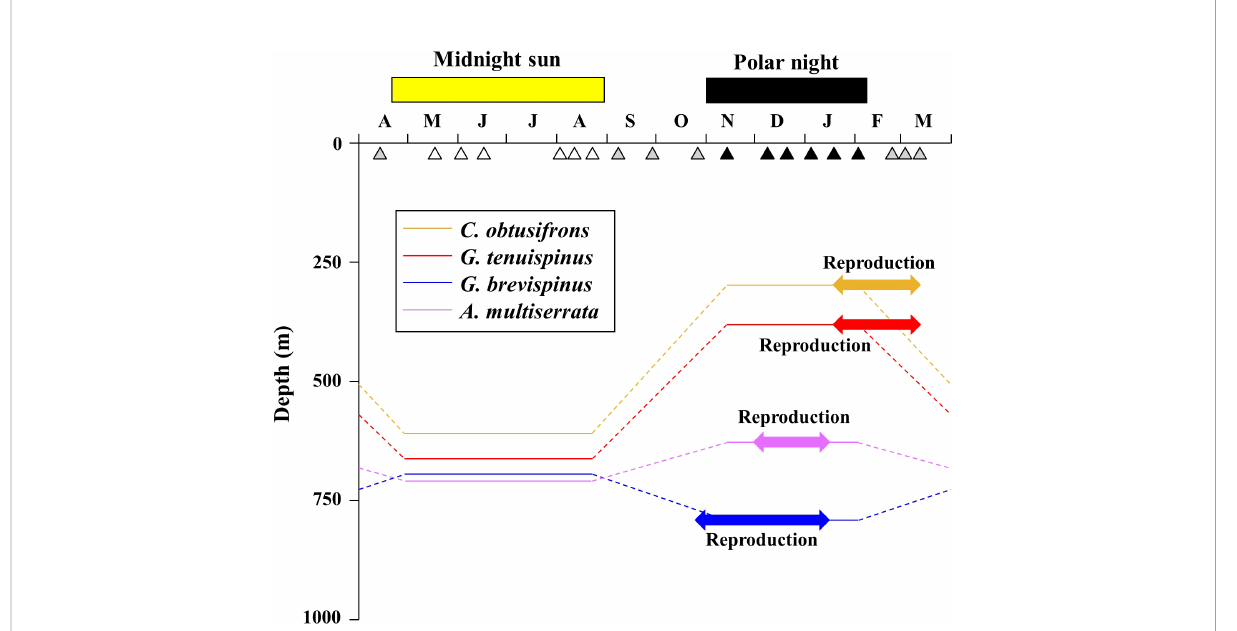
FIGURE 7 Schematic diagram showing seasonal changes in vertical distribution and timing of reproduction of four of the dominant Aetideidae copepods in the western Arctic Ocean. The open, solid, and grey triangles indicate the sampling dates during the midnight sun, polar night, and their transition periods, respectively. The shallower-dwelling species are Chiridius obtusifrons , Gaetanus tenuispinus , G. brevispinus , and Aetideopsis multiserrata